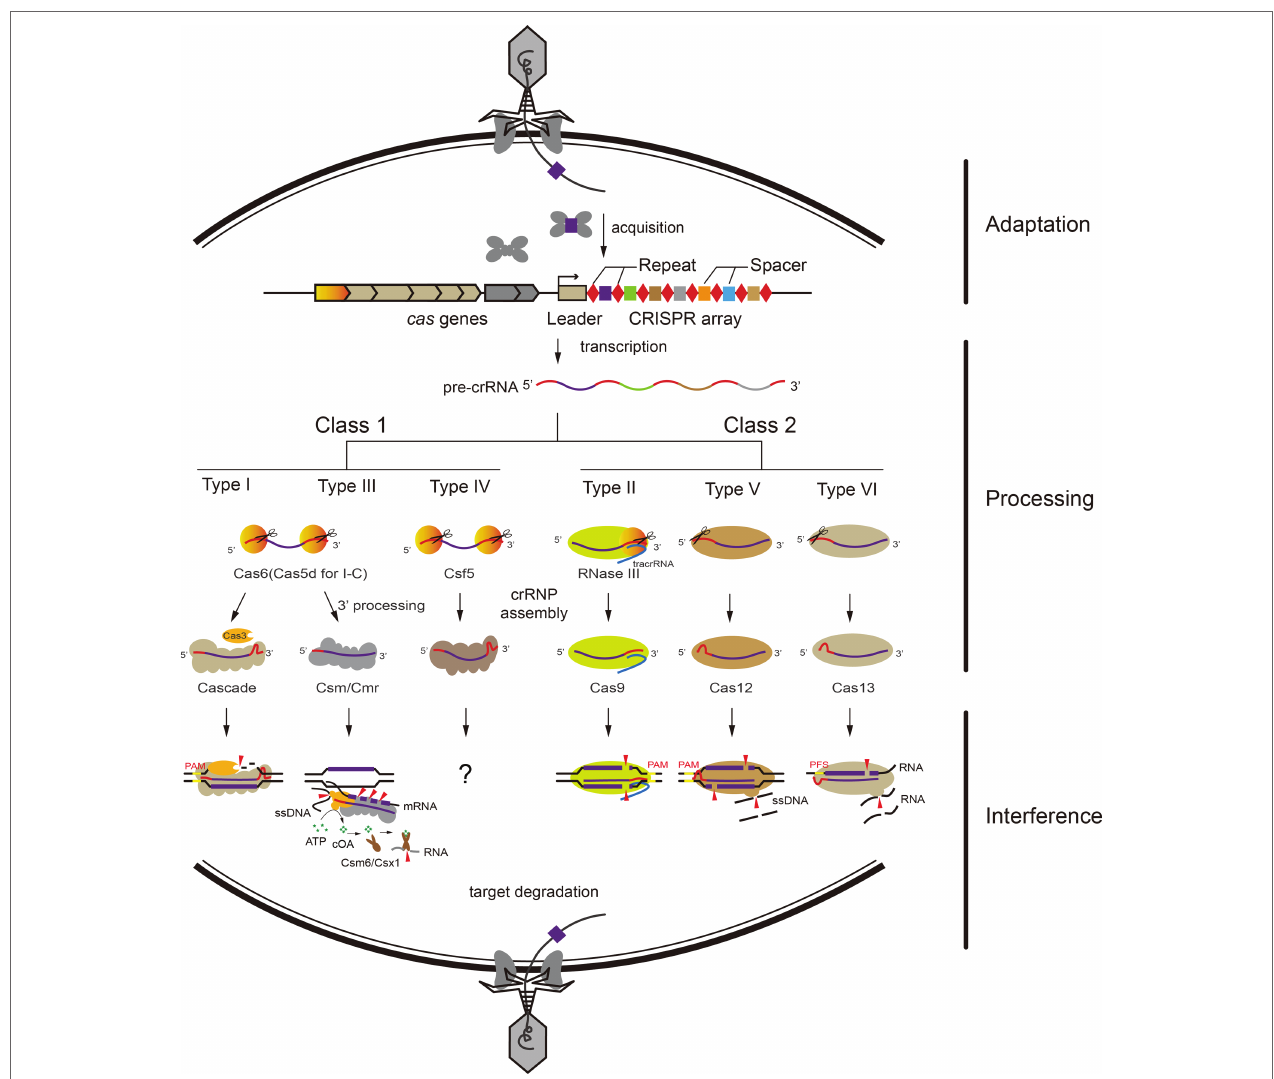
FIGURE 1 | Overview of adaptive immunity by CRISPR-Cas systems. The adaptive immunity by CRISPR-Cas systems functions in three stages: adaptation, processing, and interference. General pathways for Class 1 and Class 2 CRISPR-Cas systems exist. (1) Short fragments of invading nucleic acids are acquired as new spacers into the CRISPR locus by adaptation proteins. (2) The CRISPR locus is transcribed into pre-crRNA. In Class 1 systems, the pre-crRNA is processed into mature crRNAs by a CRISPR-associated nuclease (Cas6 for type I and III, Cas5d for type I-C, Csf5 for type IV). In Class 2 systems, Cas9 binds and stabilizes the tracrRNA:crRNA duplex and further recruits RNase III for crRNA processing. Type V and VI effector proteins process nuclease activity for crRNA maturation by themselves. (3) Mature crRNAs guide CRISPR-Cas effector complexes to cleave invading nucleic acids via their respective mechanism, relying on sequence complementarity between the crRNA and the target